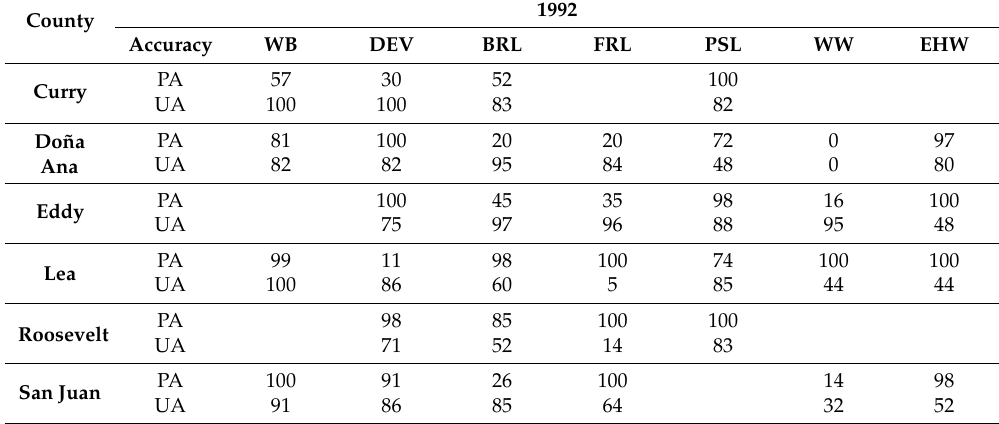
Table A2. User’s and producer’s accuracy for the rest of the LULC classes for the NLCD map of 1992.